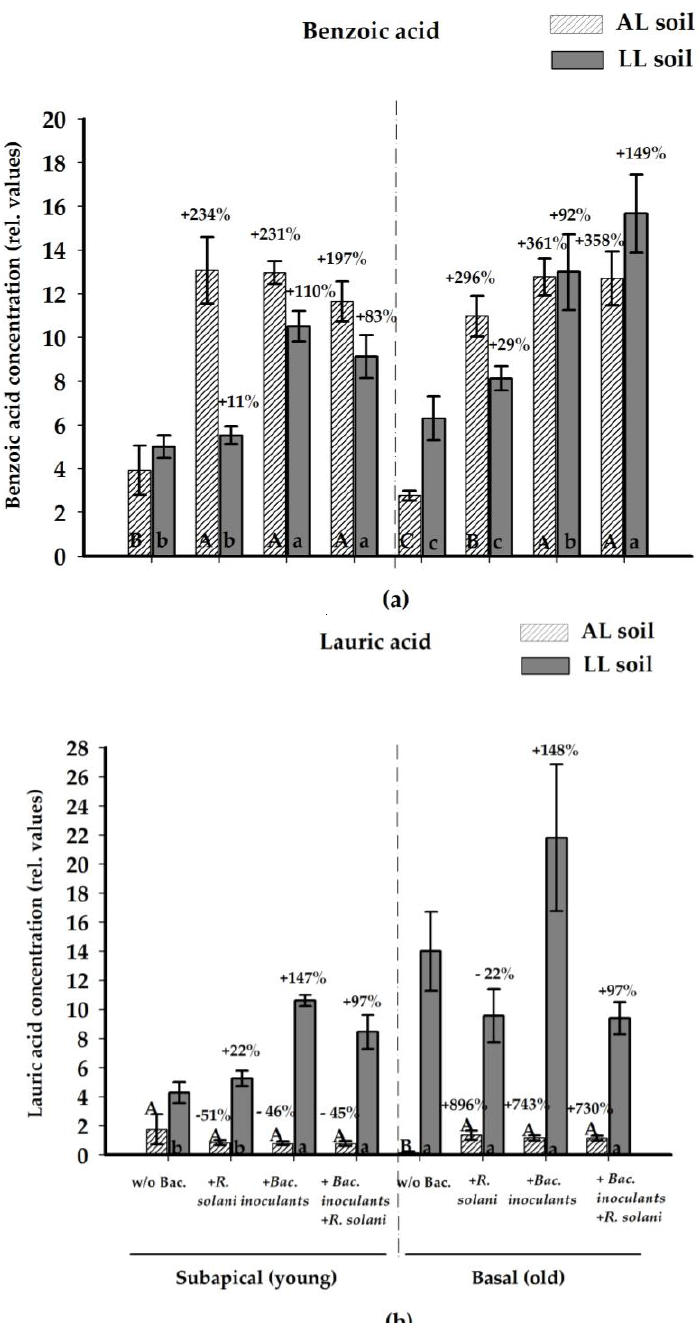
Figure 5. Concentrations and relative changes (% compared to the untreated controls) of benzoic acid ( a ) and lauric acid ( b ) in rhizosphere soil solutions collected from 1–2 cm subapical regions of young roots and from older basal root zones (8–9 cm basal roots) of Lactuca sativa L. cv. Tizian. The plants were grown on alluvial loam (AL) and loess loam (LL) treated without bacterial inoculation (w/o Bac.), with Rhizoctonia solani AG1-IB ( +R. solani ), with bacterial inoculants ( +Bac. inoculants = Pseudomonas jessenii RU47 and/or Serratia plymuthica 3Re-4-18) and with a combination of bacterial inoculants and Rhizoctonia solani AG1-IB (+ Bac. inoculants +R. solani ). Relative values based on peak area (GC-MS analysis) after subtraction of background levels in bulk soil samples. Means ± standard errors of 3–9 independent replicates. For each soil type, different characters indicate significant differences (one-way ANOVA, Holm-Sidak test, p =